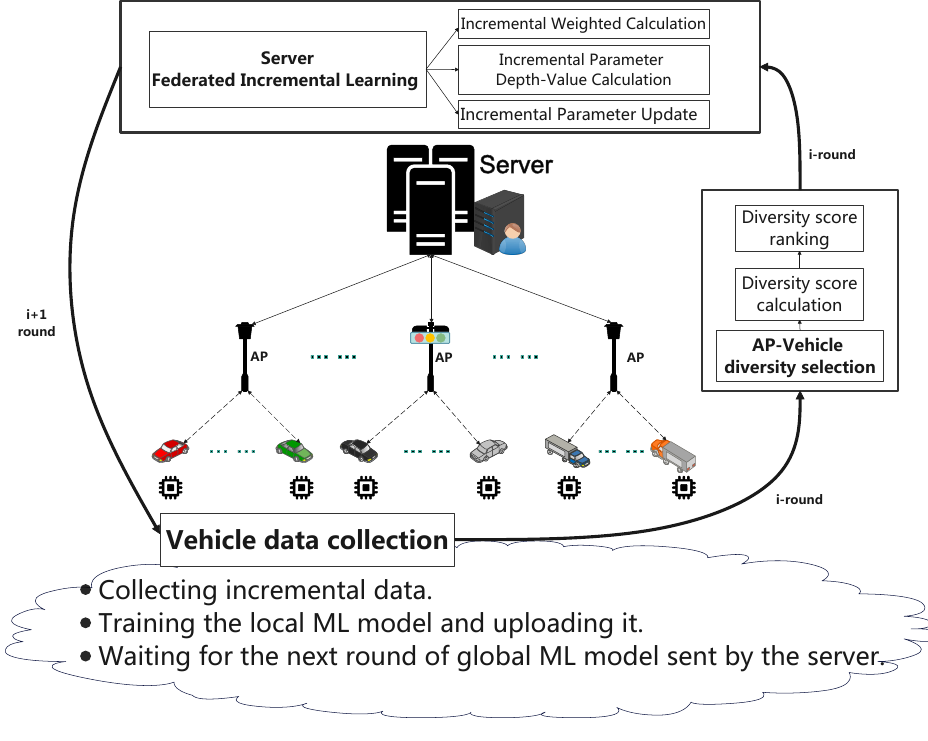
Figure 3. The proposed Fed-IW&DS